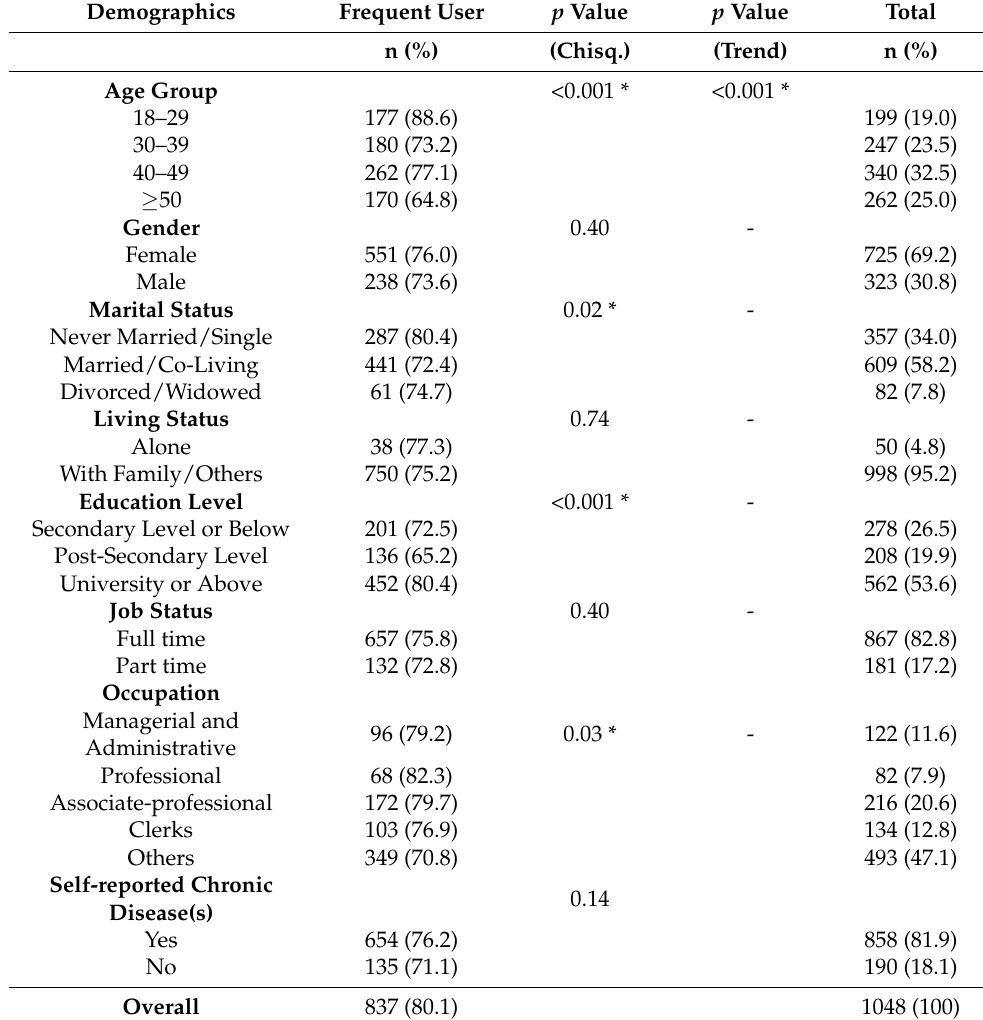
Table 4. Summary of frequent users of social media (weighted with